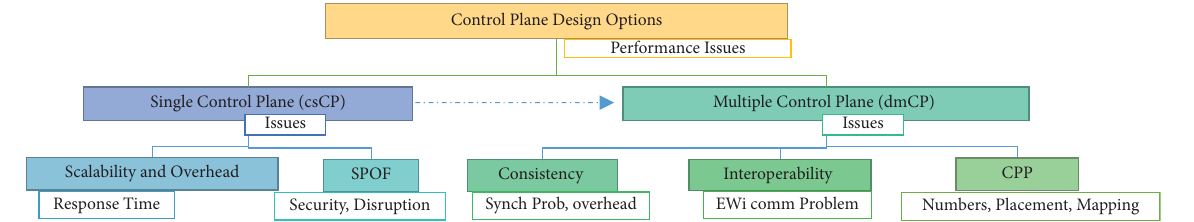
Figure 3: Taxonomy of SDN control plane performance issues.